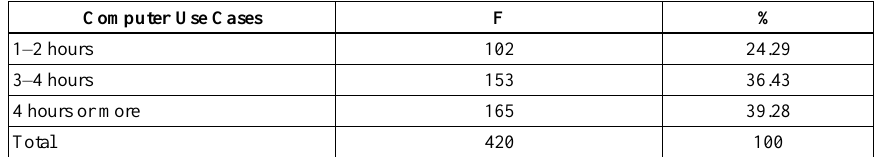
Table 2. Computer usage status of university